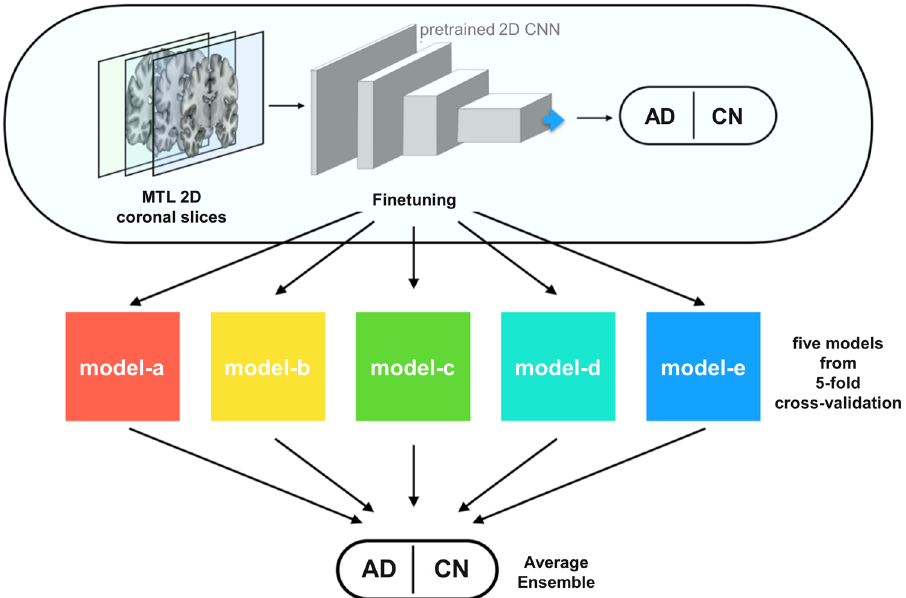
Figure 3. Training of the coronal slice-based AD classification model. We performed stratified fivefold cross- validation to distribute the samples equally by considering class balance between the training set and validation set. The average ensemble values of the average probabilities of the models (models a to e) generated from cross- validation are then used as the final results in the testing